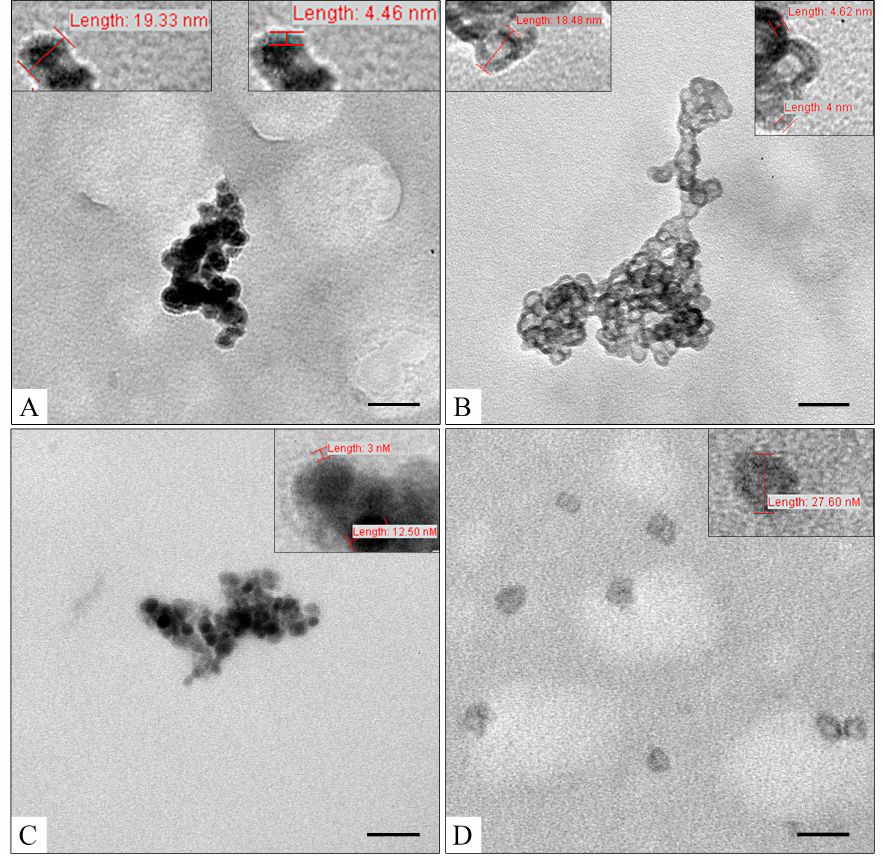
Figure 4. TEM images of MNP_Ny ( A ), NC1 ( B ), MNP_OA_Ny ( C ), and NC2 ( D ). The bar indicates 50 nm.